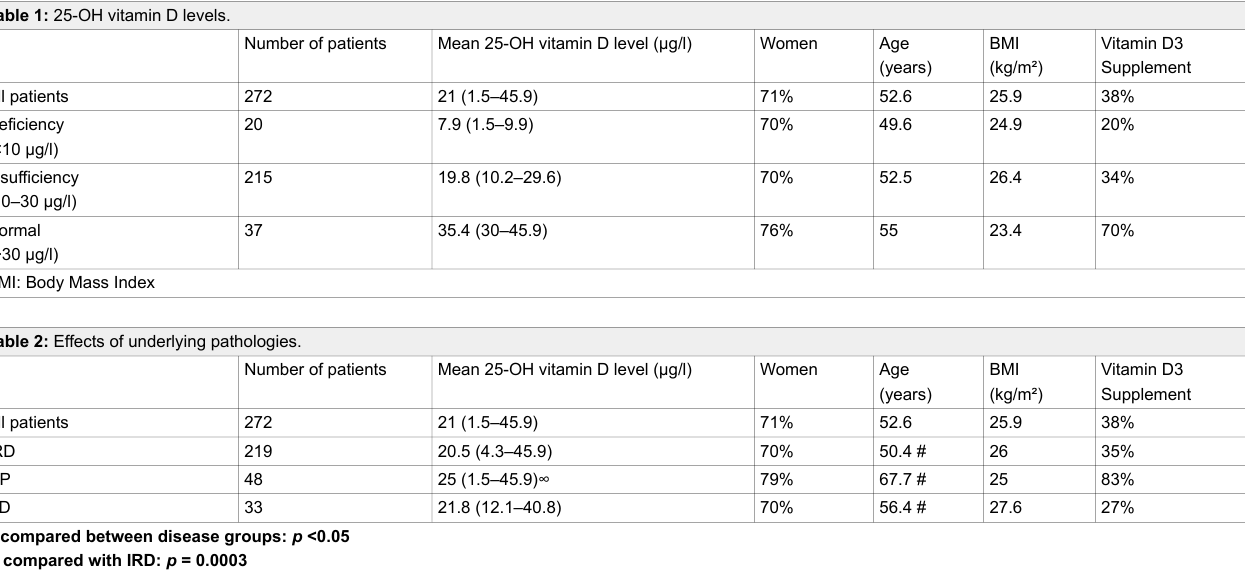
BMI: Body Mass Index, IRD: Inflammatory Rheumatic Disease, OP: Osteoporosis, DD: Degenerative